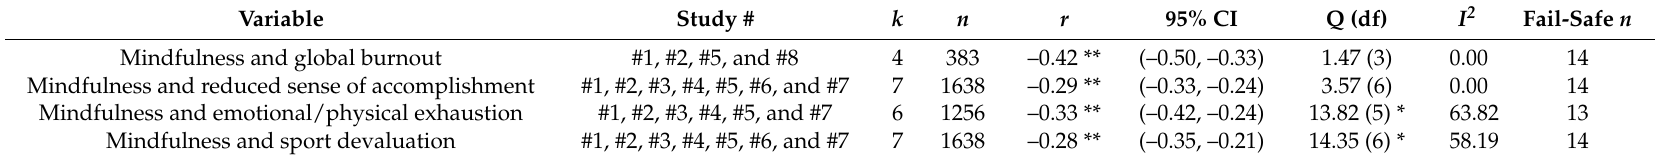
Table 2. Meta-analytic results of the relationship between mindfulness and